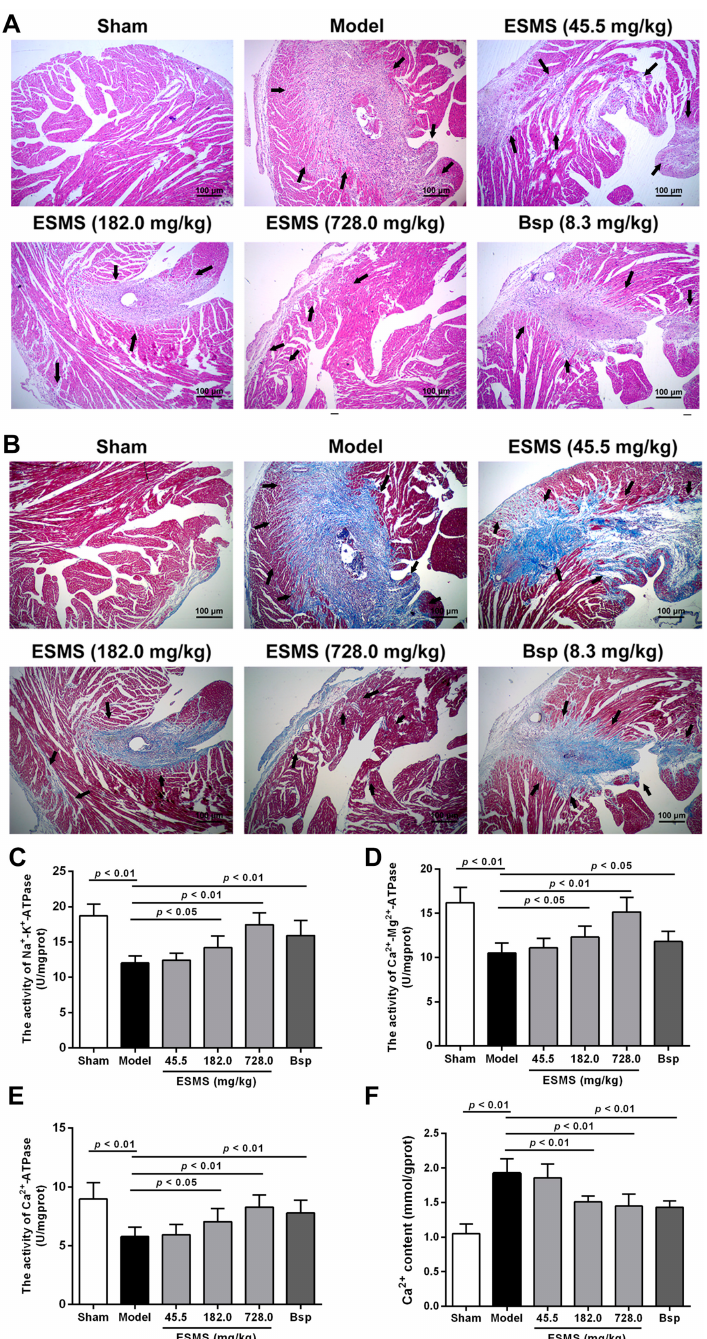
Figure 2. ESMS ameliorated cardiac pathological changes and fibrosis, increased ATPase activity and reduced intracellular Ca 2+ levels in MI-induced HF mice. ( A ) Histopathological changes of representative myocardium sections were measured by H&E staining (200 × magnification). The arrow indicates cardiac pathological changes. Bar is 100 µ m ( n = 6); ( B ) Myocardial fibrosis was measured by Masson staining (200 × magnification). Left ventricular wall fibrosis (collagen staining in blue color) was increased, and the arrow indicates interstitial fibrosis. Bar is 100 µ m ( n = 6); ( C – E ) Na + -K + -ATPase, Ca 2+ -Mg 2+ -ATPase, Ca 2+ -ATPase activity was determined in tissue after three weeks of CAL in mice ( n = 8); ( F ) Intracellular Ca 2+ levels were determined in tissue after three weeks of CAL in mice ( n = 8). Results were presented as mean ± SD. Bsp = Bisoprolol (positive